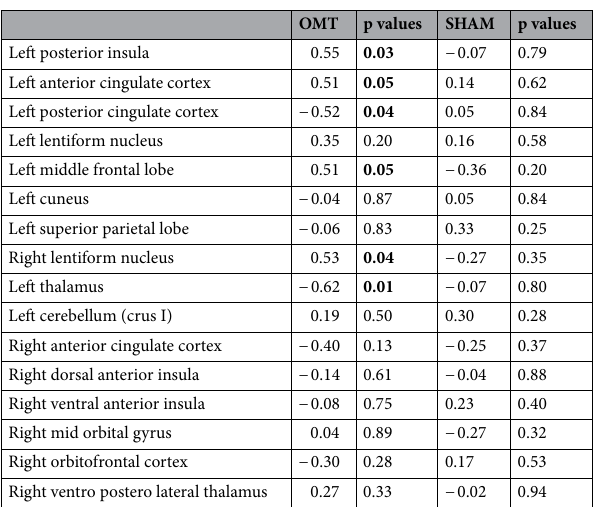
Table 3. Correlation values between baseline change response of rCBF and VAS pain score at T2. Bold values showed statistically significant